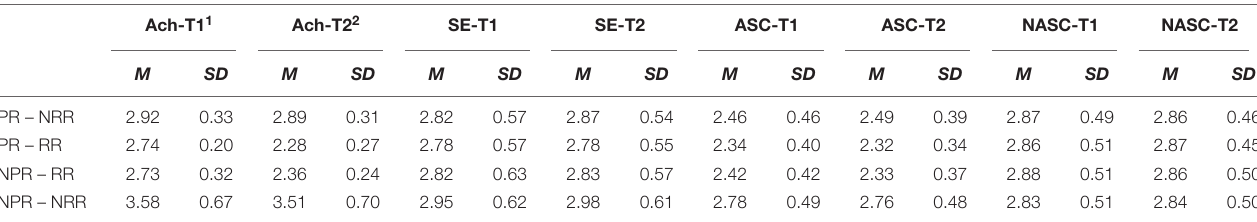
TABLE 2 | Mean and standard deviation for the four groups for achievement and self-related